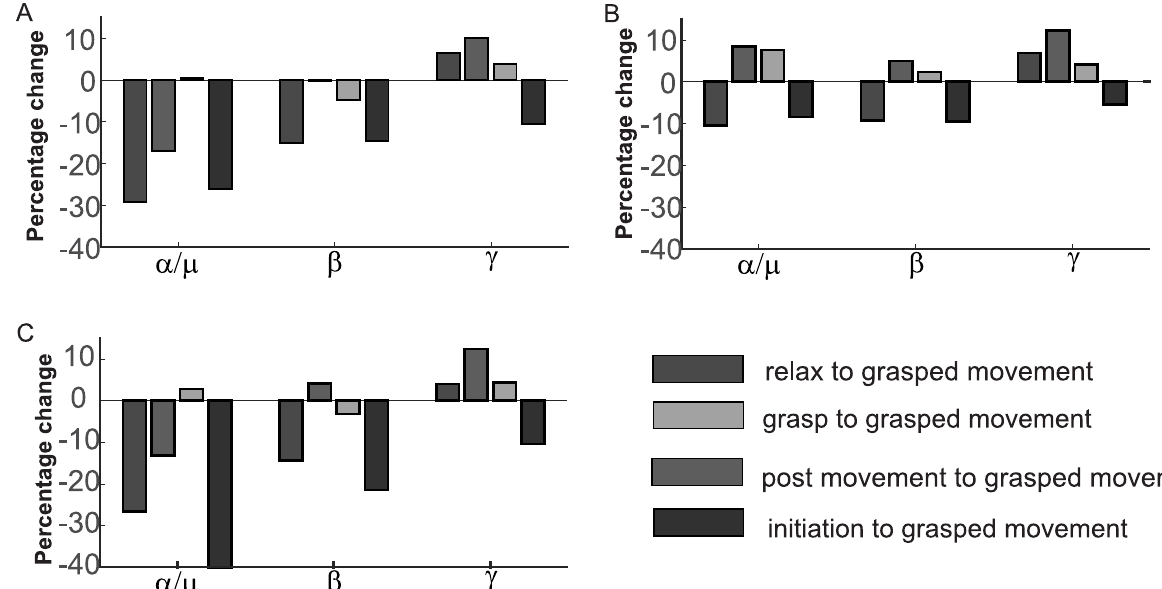
Fig 4. Increased post movement activity by rebound β and γ oscillations. (A) α / μ oscillations show 26% decrease from initiation to grasp movement 29% decrease from relax to grasp movement and 16% decrease from grasp movement to post movement in the central electrode regions. 14% and 10% decrease in beta and gamma oscillations from initiation to grasp movement and rebound increment of 14% beta and 20% gamma for post grasp movement. (B) Frontal region has shown 7% increase of alpha oscillations from grasp to grasped movement and 8% increase post movement (C) Parietal region electrodes has shown 21% and 20% decrease from initiation to grasp movement and rebound increment of 4% and 12% post movement. (For inter subject variability see S3 Fig in S1 File).